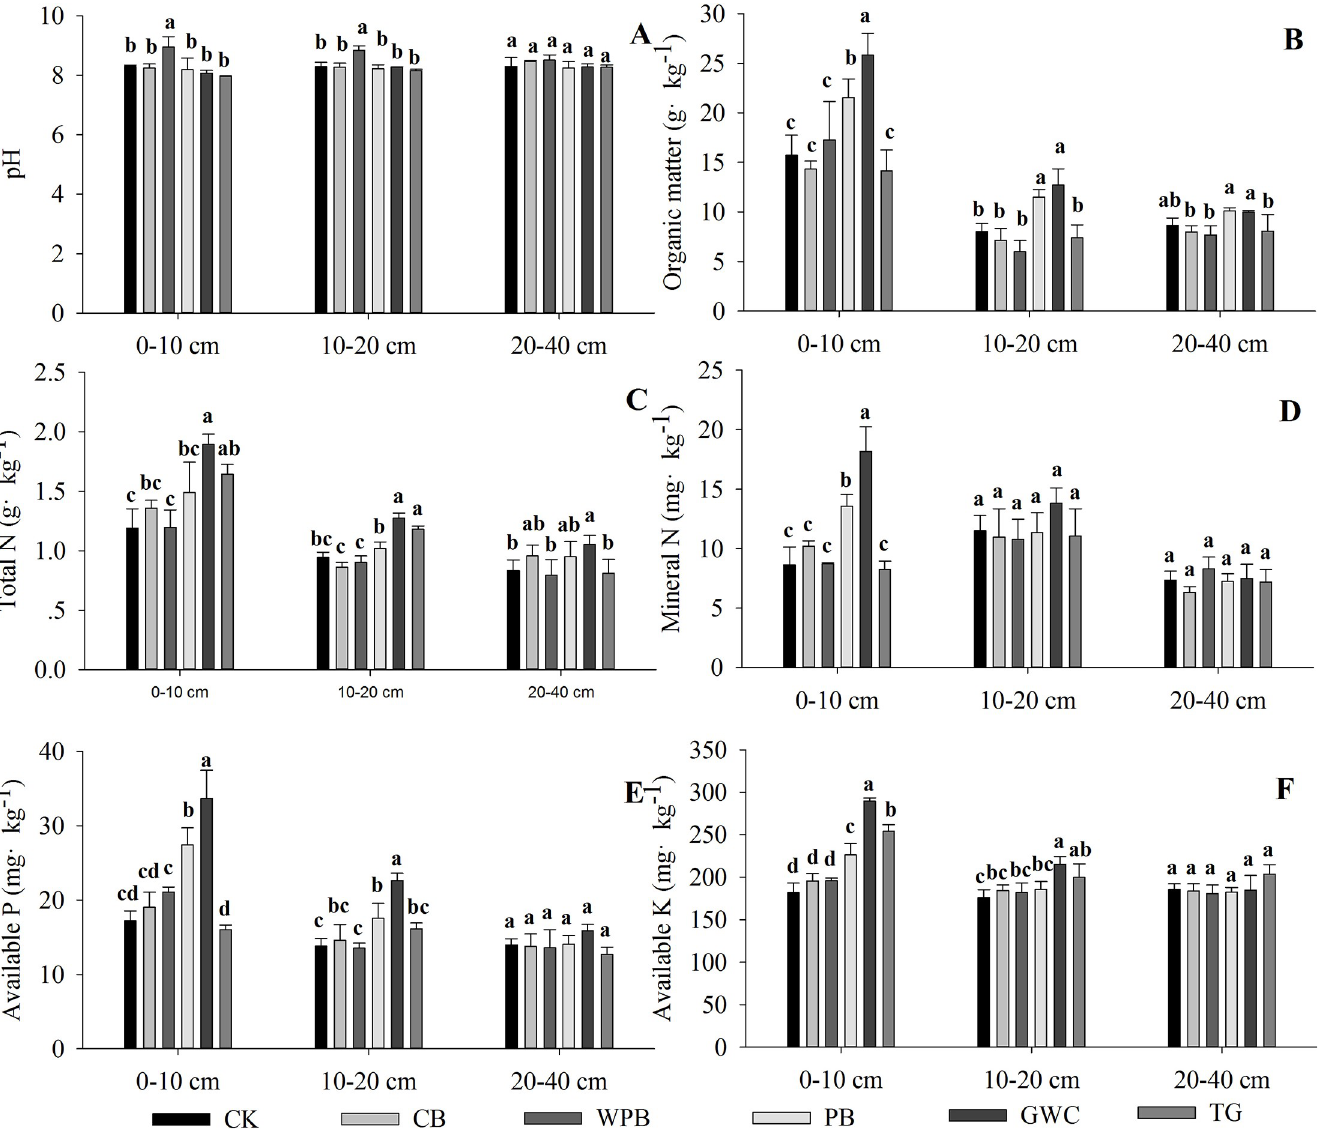
Fig 3. Soil chemical properties at three different depths in the urban tree pits treated with bare soil (CK), cobblestones (CB), water permeable bricks (WPB), pine barks (PB), green waste compost (GWC), and turf grass (TG) two years after mulching. Different letters above the error bars indicate significant differences between treatments ( p < 0.05, n = 3). The error bars indicate standard